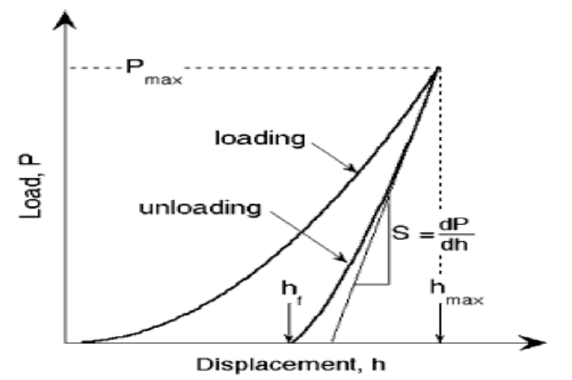
Figure 14. Schematic illustration of indentation load-displacement data showing important measured